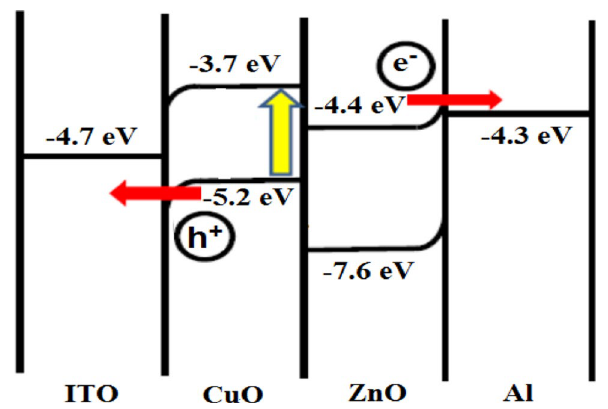
Fig. 7 Energy level diagram of ITO/CuO/ZnO/Al device